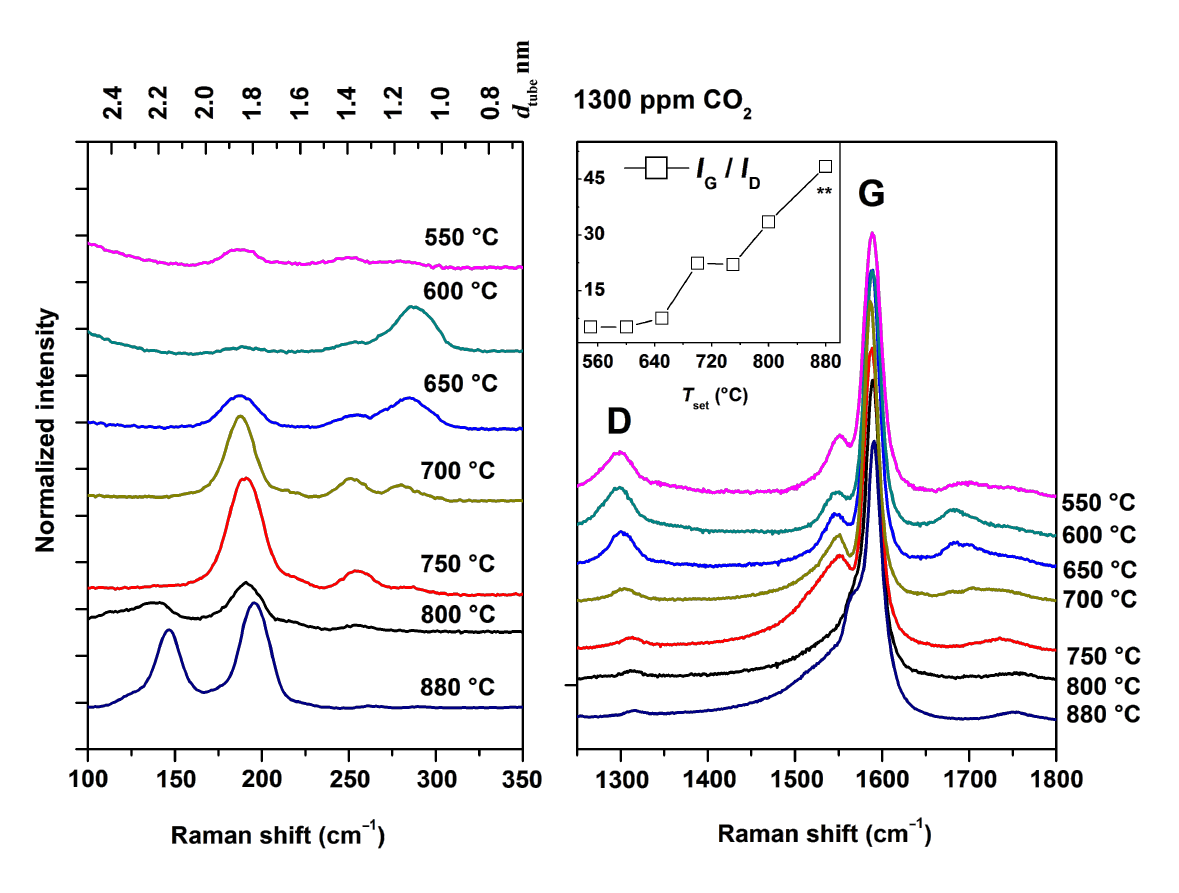
Figure 4: RBM modes (left) and D and G bands (right) of resonant Raman spectra recorded from SWCNTs synthesized under different temperature conditions (550–880 °C). The inset plots the ratio of G and D band intensities ( I G / I D ) with increasing T set . Laser wavelength of the Raman system was 632.82 nm (1.96